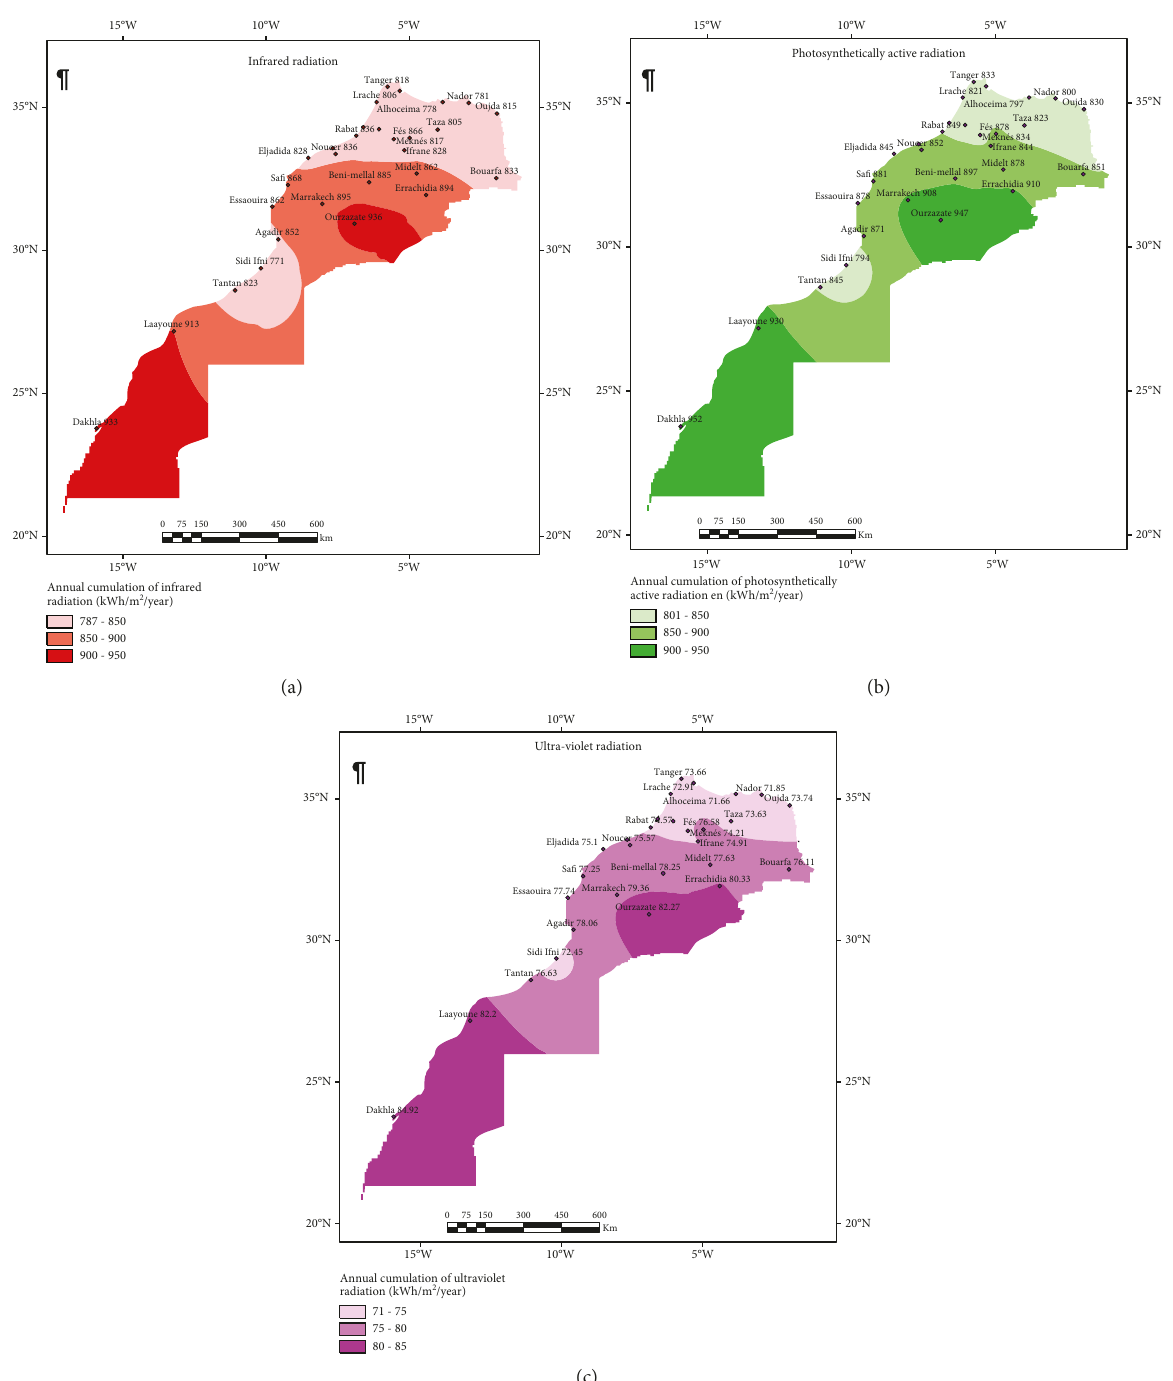
H H UVT , PAR , and IR ) on the